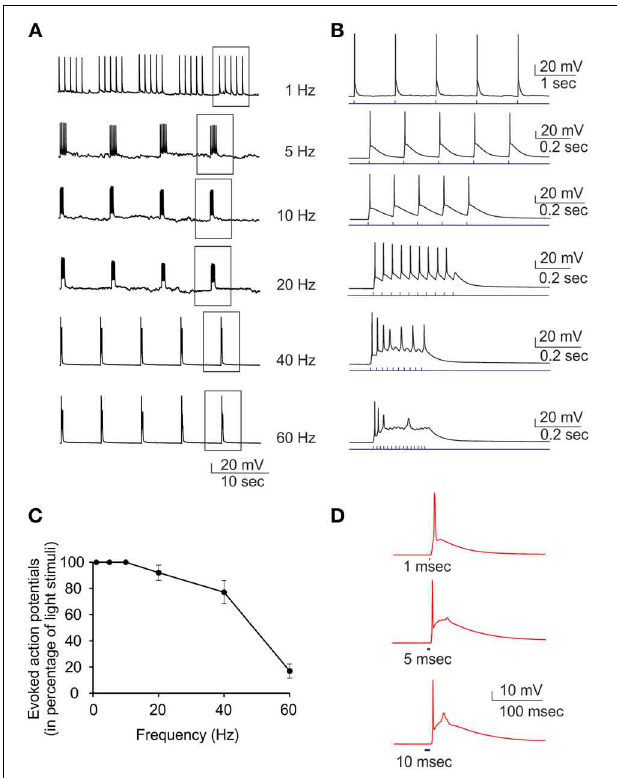
FIGURE 3 | Current-clamp characterization of ChR2/H134R-expressing neurons. Single light pulses at 470nm induce action potentials in neurons transduced with ChR2/H134R. (A) Representative traces showing the induction of action potentials by light pulses at increasing stimulation frequency (1–60Hz). (B) Single trains boxed in panel (A) are shown in an expanded time scale. (C) Percent of successful action potential induced by light pulses as a function of the stimulation rate. Means ± s.e.m. are reported ( n = 7). (D) Representative traces of single action potentials induced by light pulses of increasing duration (1, 5, and 10ms). The afterdepolarization that limits the maximum frequency of light stimulation is clearly visible and increases with the pulse